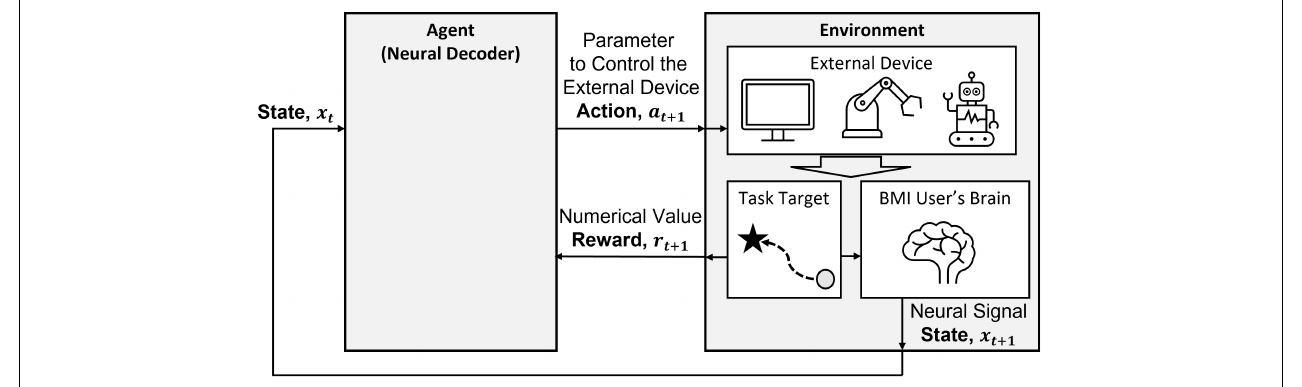
FIGURE 2 | RLBMI architecture with labeled RL components. This figure is modified based on Figure 1 in DiGiovanna et al. (2009).